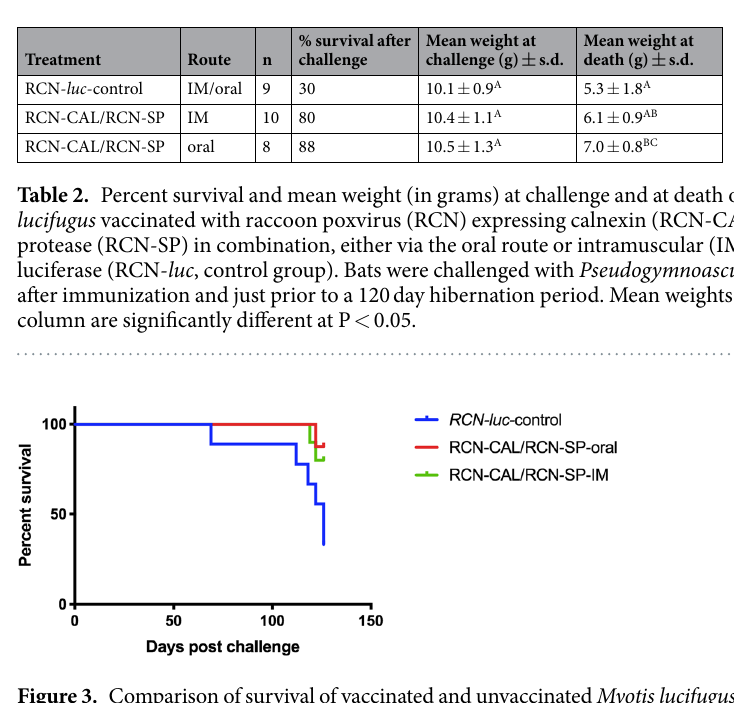
Figure 3. Comparison of survival of vaccinated and unvaccinated Myotis lucifugus . KaplanMeier survival analysis shows that bats vaccinated with a combination of raccoon poxvirus (RCN) expressing calnexin (RCN-CAL) and RCN expressing serine protease (RCN-SP), either via the oral route or intramuscular (IM) route, survived at a significantly (P = 0.01) higher rate than control bats receiving RCN expressing luciferase (RCN- luc